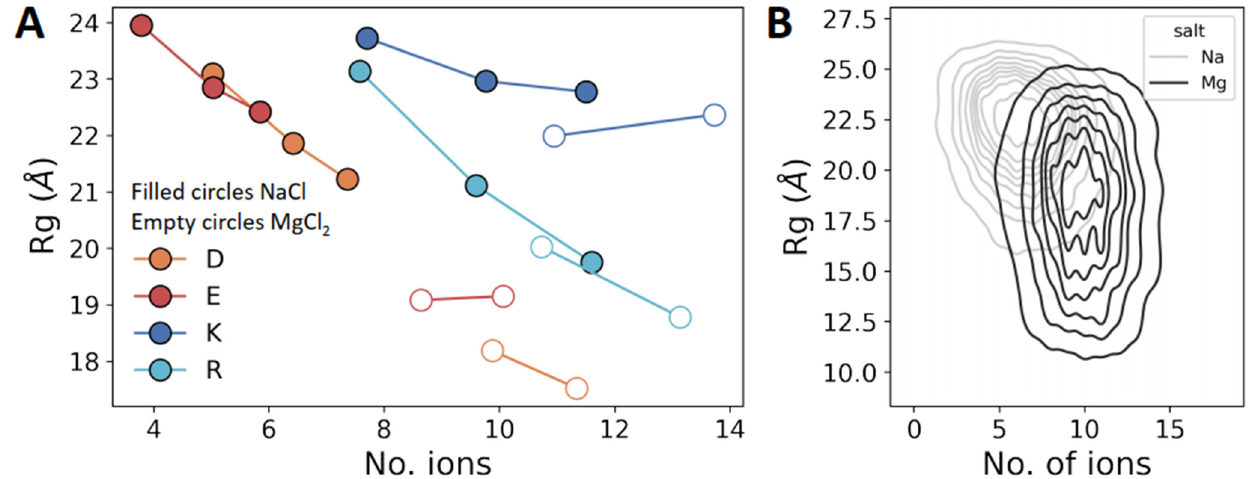
Figure 5. Ion adsorption on charged homo-polypeptides. ( A ) Mean Rg for each system as a function of the mean number of ions adsorbed on each charged homo-polypeptide. The three data points for each charged homo-polypeptide were obtained using simulations at three different concentrations of NaCl (0 M, 0.125 M, and 0.25 M) and two salt concentrations for MgCl 2 (0.125 M and 0.25 M). The highest number of adsorbed ions for each system corresponds to simulations at a salt concentration of 0.25 M, with the lowest number of adsorbed ions being found at a salt concentration of 0 M. Filled and empty circles correspond to NaCl and MgCl 2 , respectively. ( B ) Two-dimensional distribution of Rg versus number of adsorbed sodium (blue) or magnesium (orange) ions for polyE when simulated in the presence of 0.125 M NaCl or MgCl 2 . Ion adsorption is defined based on a cutoff distance of 4 Å of the ions from any peptide atom, and the number of adsorbed ions is quantified by averaging the ions that satisfy the cutoff throughout the analyzed